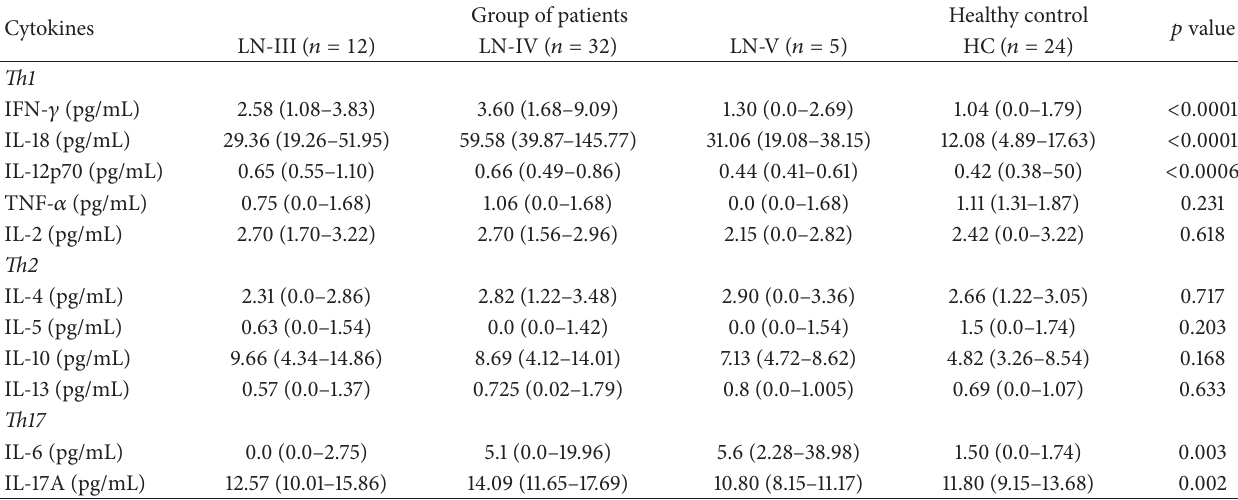
Table 2: Comparisons of serum Th1, Th2, and Th17 cell expressed cytokines in different classes of lupus nephritis and healthy control. Cytokines